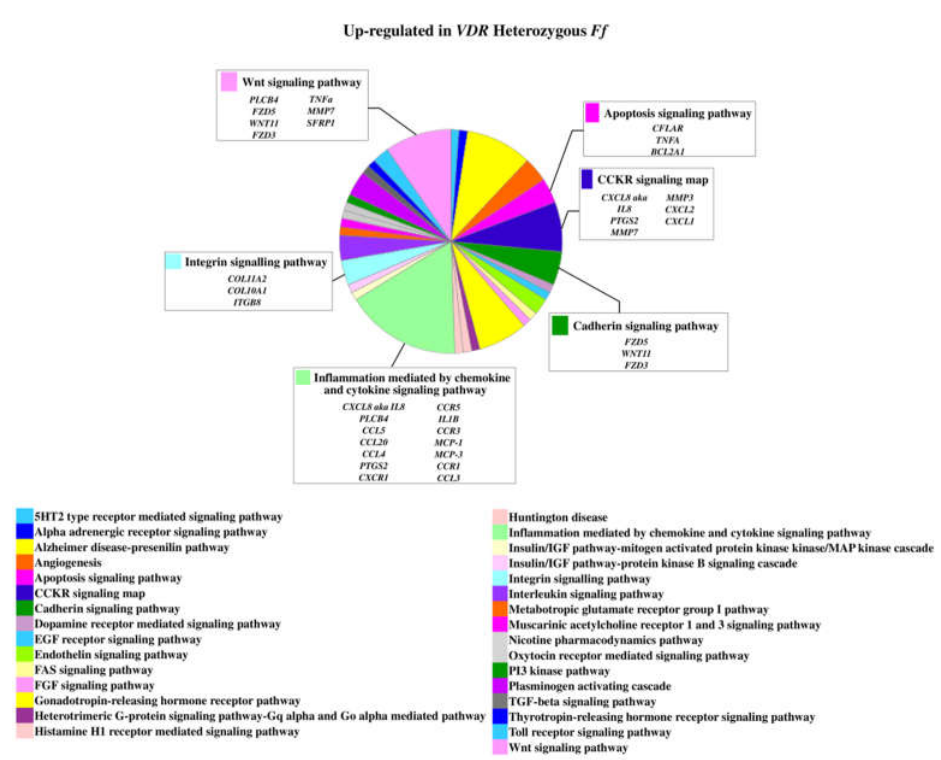
Figure 2. Downregulated genes and related pathways in heterozygous Ff disc cells. Pie chart obtained by Panther.